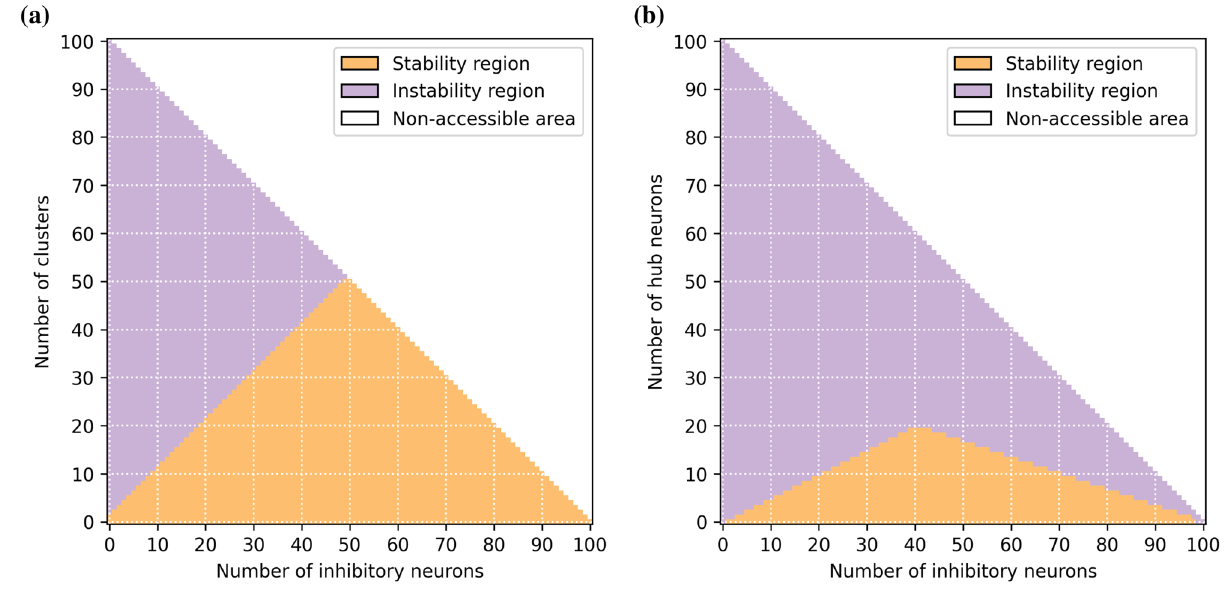
Figure 6. ( a ) Regions of stability (orange) and instability (purple) of the structural modules versus the number of clusters initially present in the weight matrix and the number of inhibitory neurons in the network. The line separating the two regions represents the upper limit to observe M independent clusters versus the number of 1 inhibitory neurons. ( b ) Regions of stability (orange) and inhibitory neurons. This limit corresponds to M − instability (purple) of the two clusters versus the number of excitatory neurons encoding for the two stimuli (hub neurons) and the number of inhibitory neurons in the network. The lines separating the two regions represent the minimal number of inhibitory neurons N I required to observe two clusters with N H hubs. For 2 N the line is given by N I N I 2 N H 1 . For larger number of inhibitory neurons the limit is given by 5 ≤ = + N I N N E N I 3 N H . Note that both graphs have been realized for a network made of N 100 neurons = − = + = in total, of which N E are excitatory and N I inhibitory, this constraint is at the origin of the non-accessible areas (white